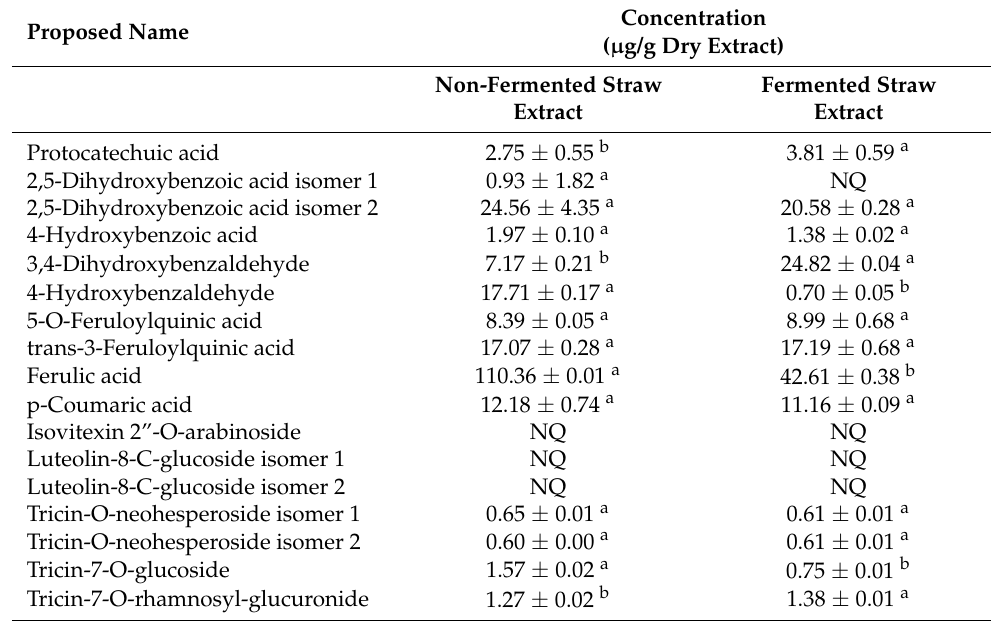
Table 3. LC-ESI-UHR-QqTOF-MS data of phenolic compounds quantified in straw extract after saccharification and with and without S. cerevisiae fermentation (means ± SD, µ g/g dry